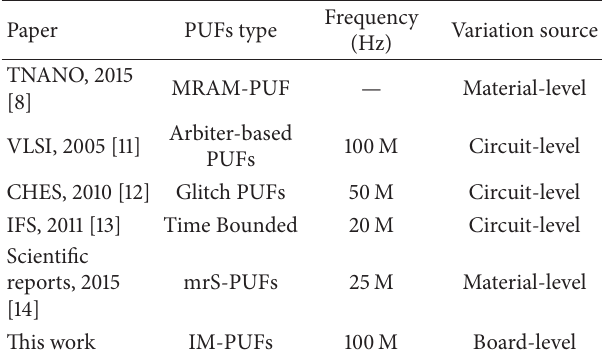
Table 1: The comparison with other